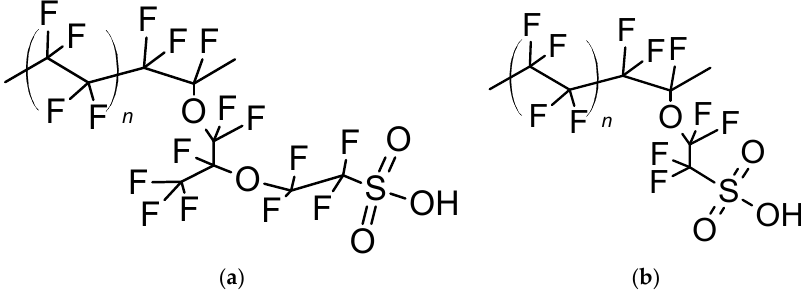
Figure 1. ( a ) Long side chain perfluorosulfonic acid (LSC-PFSA) Nafion ® 1100 ( n = 6.6) and ( b ) short side chain PFSA (SSC-PFSA) Aquivion ® 830 ( n = 5.5).